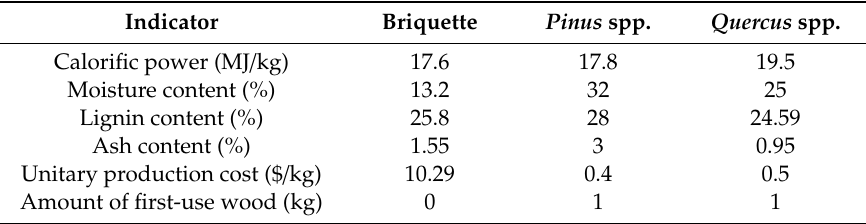
Table 9. Real values of the